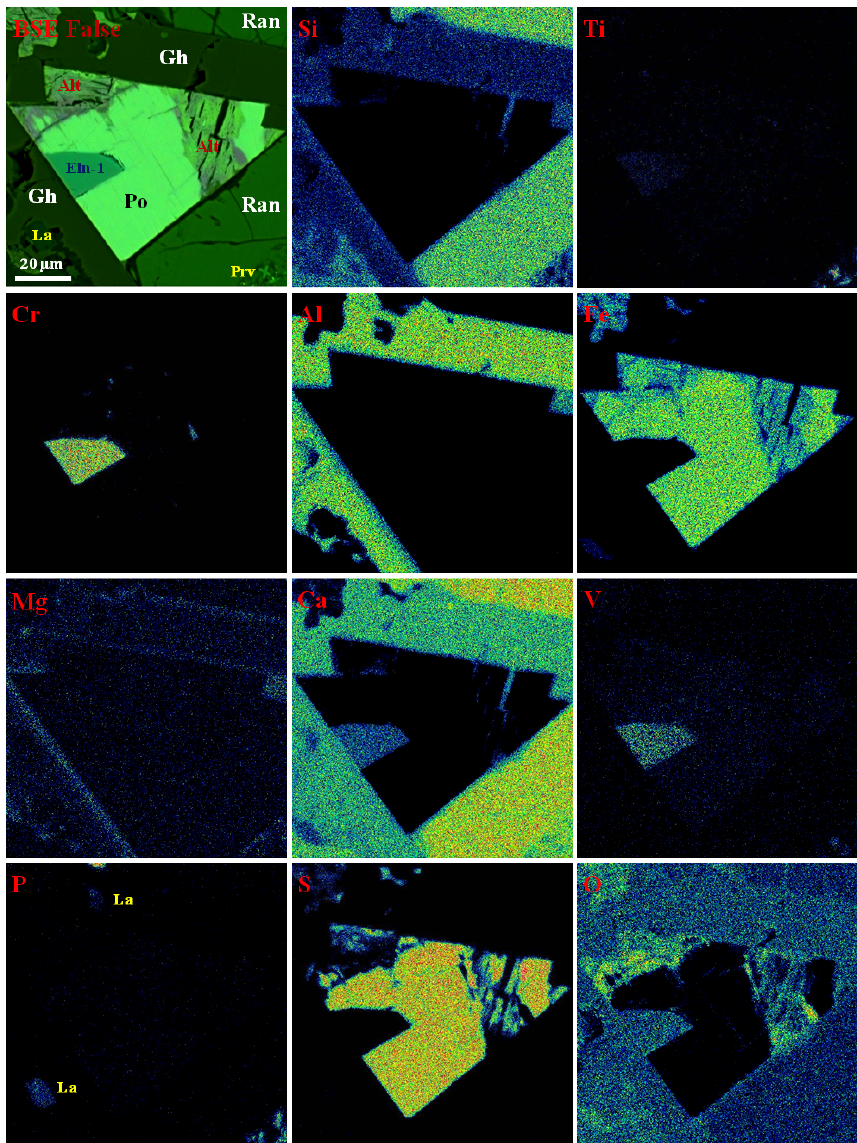
Figure 4. Elemental maps of mineral association with ellinaite-1 grain from gehlenite-rankinite paralava, Hatrurim Basin, Israel. Symbols: Eln-1 – ellinaite; Po – Cr-rich pyrrhotite; Gh – gehlenite; Ran – rankinite; La – larnite–flamite; Prv – Si-rich perovskite; Alt – alteration products after pyrrhotite. See Figs. 3a and S2 for